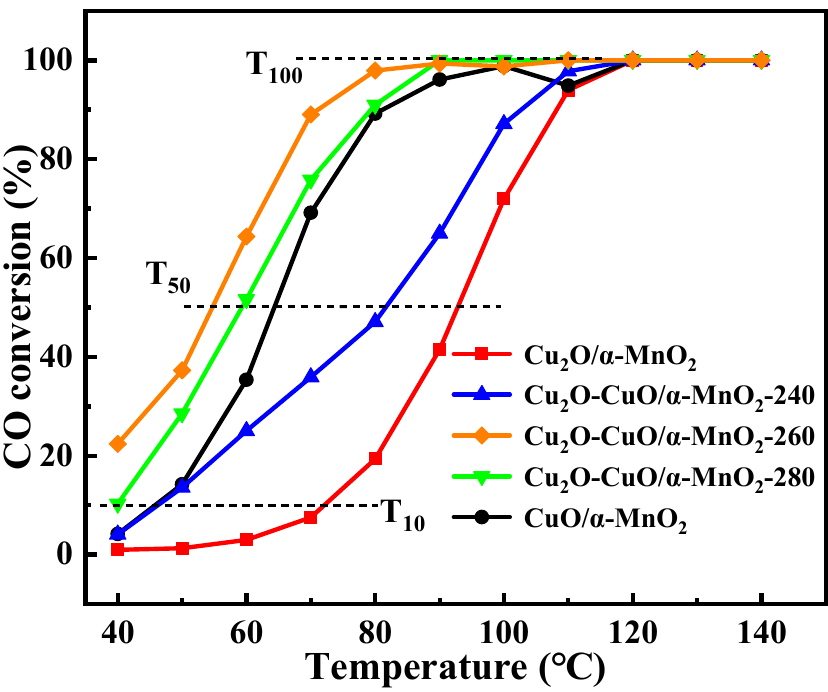
Figure 2. The curves of the CO conversion versus reaction temperature over the as-prepared Cu 2 O/ α -MnO 2 , Cu 2 O-CuO/ α -MnO 2 -T, and CuO/ α -MnO 2 -500 catalysts; reaction conditions: CO/O 2 /N 2 = 1/20/79, GHSV = 12,000 mL g − 1 h − 1 , 1 atm.